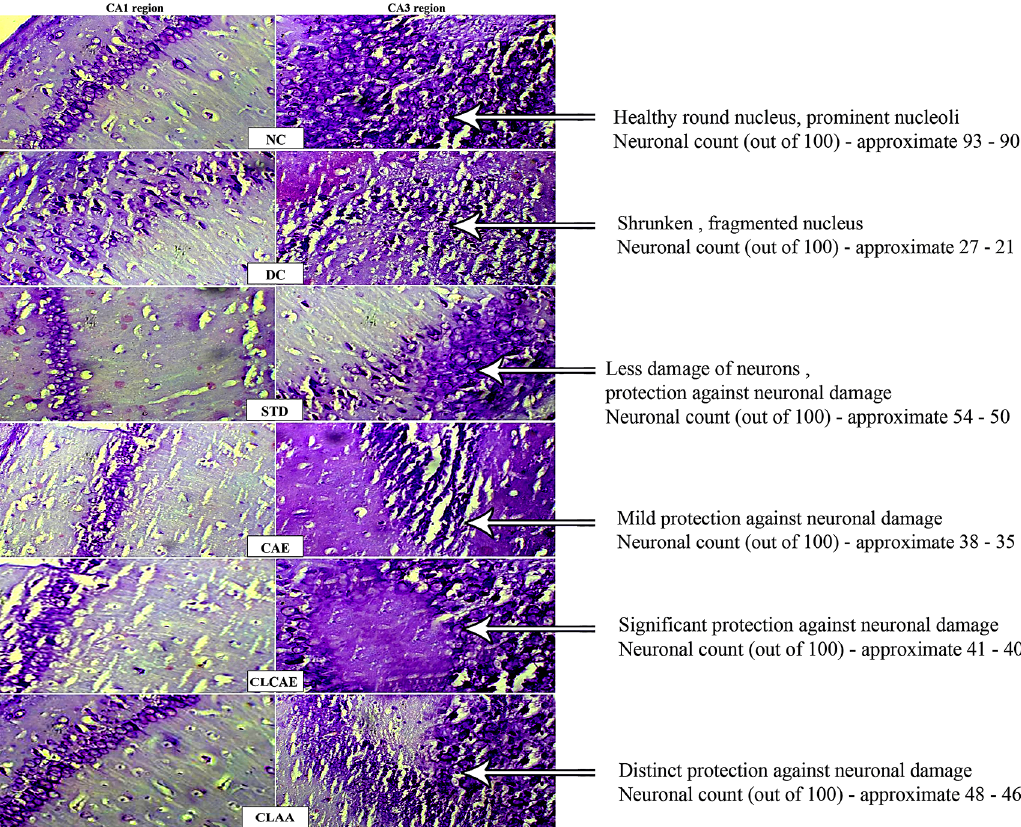
Figure10.HistopathologystudyofA)Normalcontrol,B)Diseasecontrol,C)Standard,D)CAE,E)CLCAEF)CLAA.